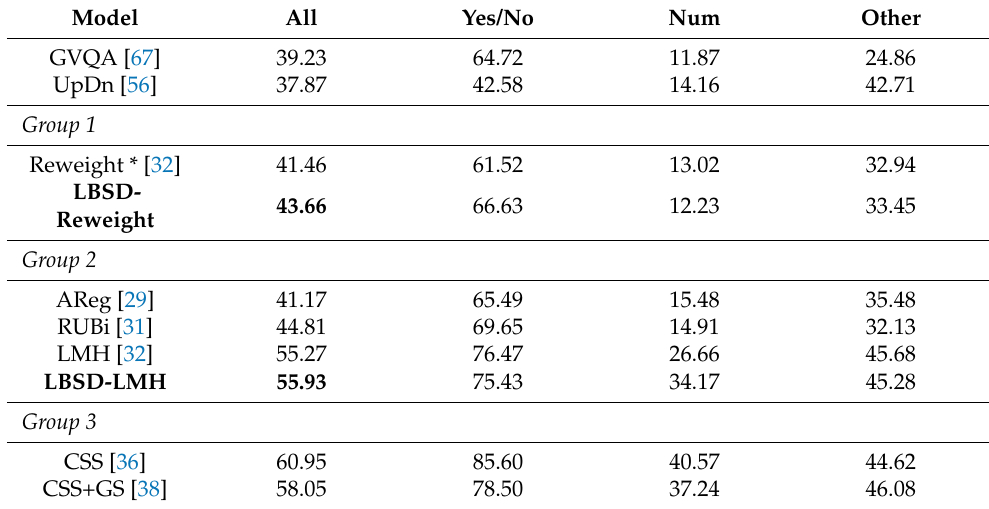
Table 7. Performance comparison (Accuracies %) with the state-of-the-art model’s accuracy on the